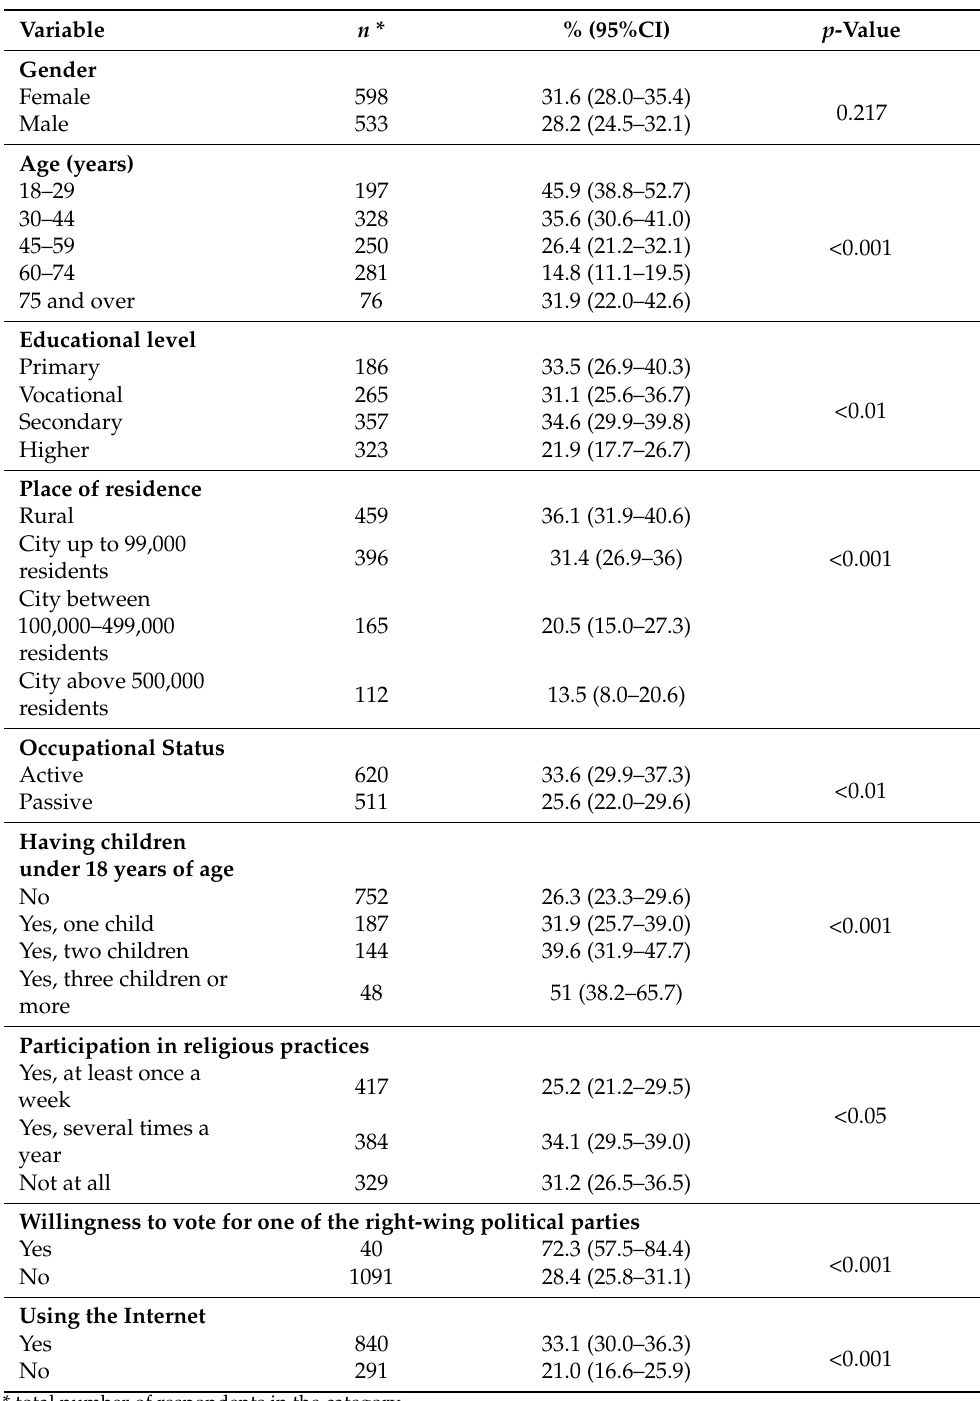
Table 2. Percentage of respondents, who declared a lack of willingness to vaccinate against COVID-19 by sociodemographic variables, Poland, April